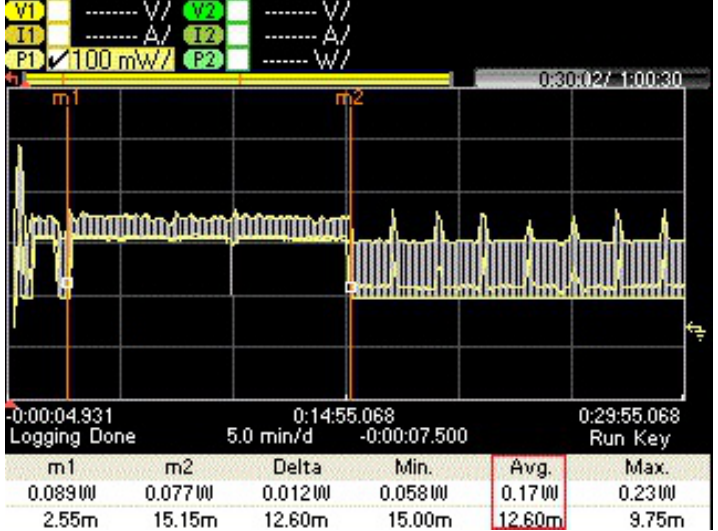
Figure 1. Power graph of the BG96 NB-IoT module when transmitting an image (1600 × 1200 pixels, 357.17 kB). A total of 239 transmissions are needed (12.60 m) with an average power of 0.17 W, which translates to an energy consumption of 0.0357 Wh.